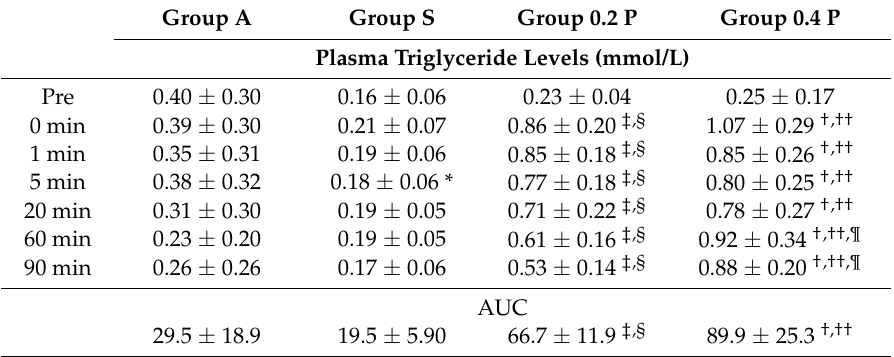
Table 4. Changes in triglyceride concentrations after the glucose challenge and the area under the curve (AUC). Pre (before anesthesia induction): each time point indicates the elapsed time after the glucose challenge; 0 min means just before the glucose injection. Data are expressed as mean ± SD.